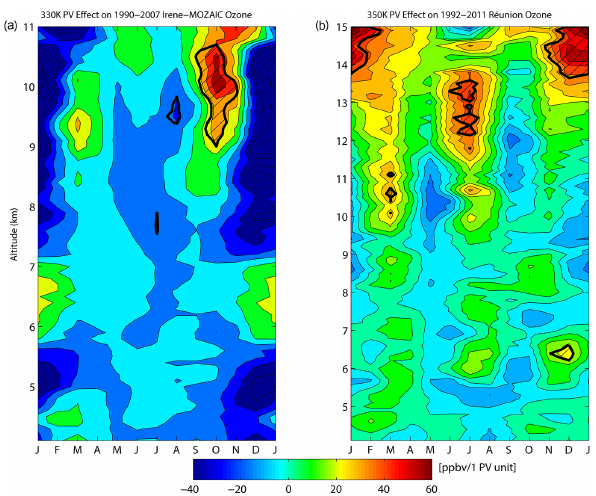
Figure 9. (a) Irene tropospheric ozone (4–11km layer) sensitiv- ity toward the 330K potential vorticity time series (ppbv1PV unit − 1 ) over the box bounded by 25.5–32.2 ◦ S and 24.8–31.5 ◦ E for 1990–2007. (b) Réunion tropospheric ozone (4–15km layer) sensi- tivity toward the 350K potential vorticity time series (ppbv1PV unit − 1 ) over the box bounded by 18–25 ◦ S and 49.5–65.25 ◦ E for 1992–2011. Statistically significant response is shaded. Note that the altitude scales are different for the